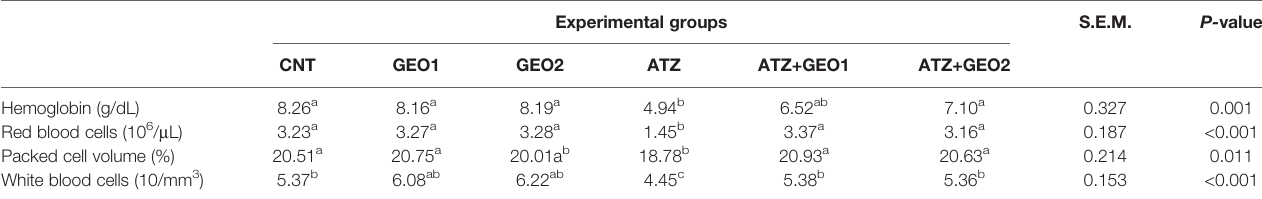
TABLE 3 | Hematological parameters of Nile tilapia in response to sub-lethal atrazine (ATZ) exposure and/or dietary supplementation with Panax ginseng essential oil (GEO) for 60 days.